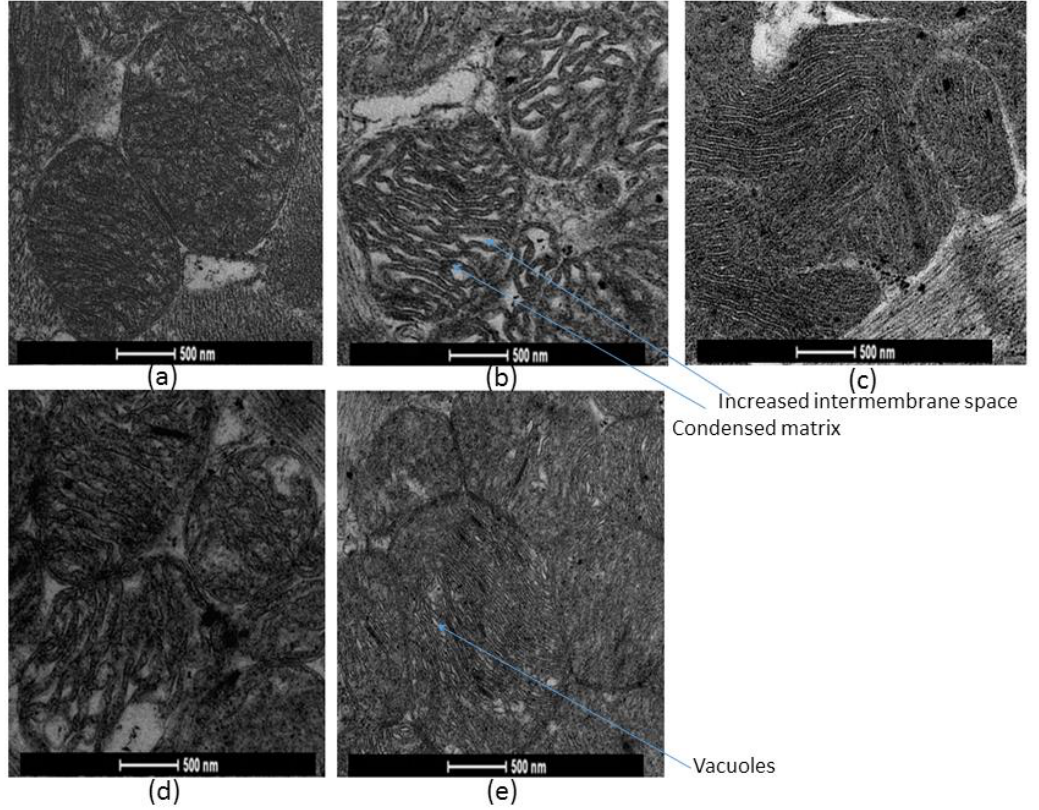
Figure 12. Morphology of mitochondria in skinned rat cardiac fibers. 5 min incubations of saponin-skinned cardiac fibers were performed in physiological salt solution at 37 ◦ C in the presence of: ( a ) pyruvate + malate (6 mM + 6 mM); ( b ) palmitoyl- L -carnitine (9 µM); ( c ) palmitoyl- L -carnitine (9 µM) + 5% dextran T-70; ( d ) pyruvate + malate (6 mM + 6 mM) and ADP/ATP carrier inhibitor carboxyatractyloside (1.3 µM); ( e ) pyruvate + malate (6 mM + 6 mM) and ADP/ATP carrier inhibitor bongkrekic acid (17.6 µM).